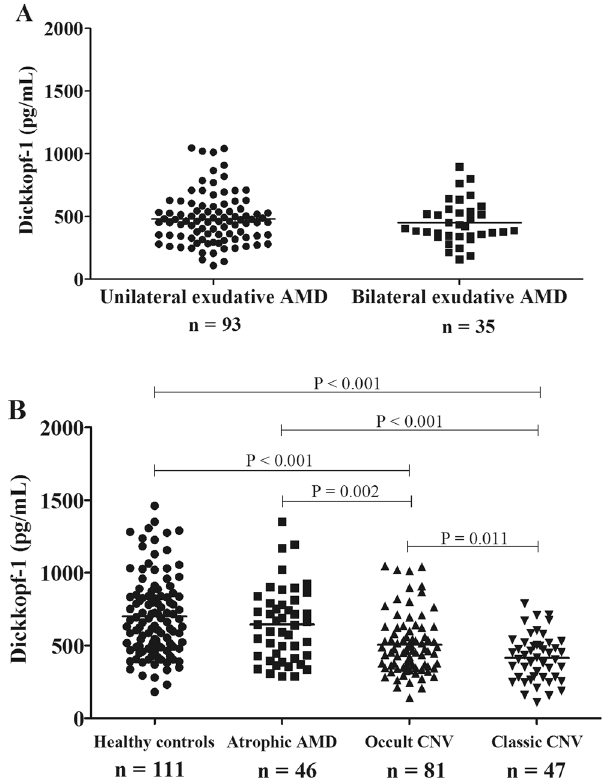
Figure 2. Lower Plasma Dickkopf-1 (DKK-1) Levels were Associated with Severity of Exudative Age-Related Macular Degeneration (AMD). ( A ) Comparison of DKK-1 levels between patients with unilateral exudative AMD and bilateral exudative AMD; ( B ) Comparison of DKK-1 levels between patients with occult CNV and classic CNV. Data were analyzed by Student’s t-test. Each spot represents one patient. Middle lines represented the mean.